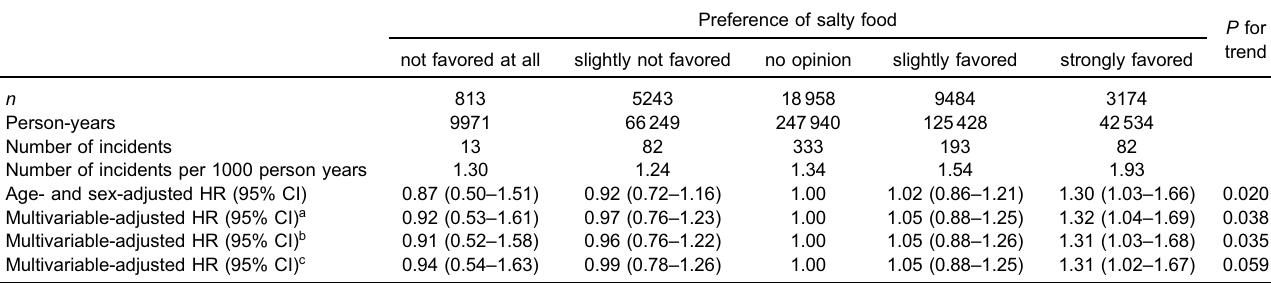
Table 4. Age- and sex-adjusted and multivariable-adjusted hazard ratios of gastric cancer according to preference of salty food